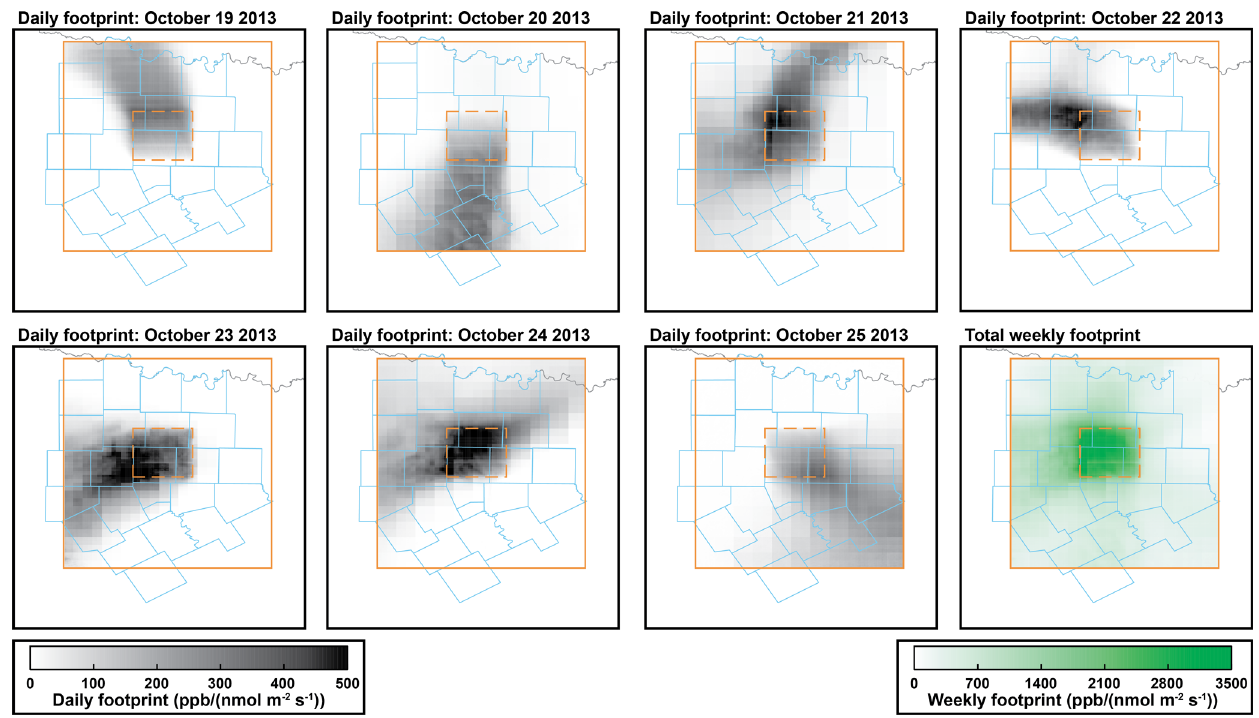
Figure 2. Summed methane column footprints for all 1.3 × 1.3km 2 grid cells in the 70 × 70km 2 observation domain defined by the dashed orange box. The footprints are calculated from 08:00 to 17:00LT over the 290 × 235km 2 domain defined by the solid orange box. Bottom right panel shows the summed footprint for the full week.